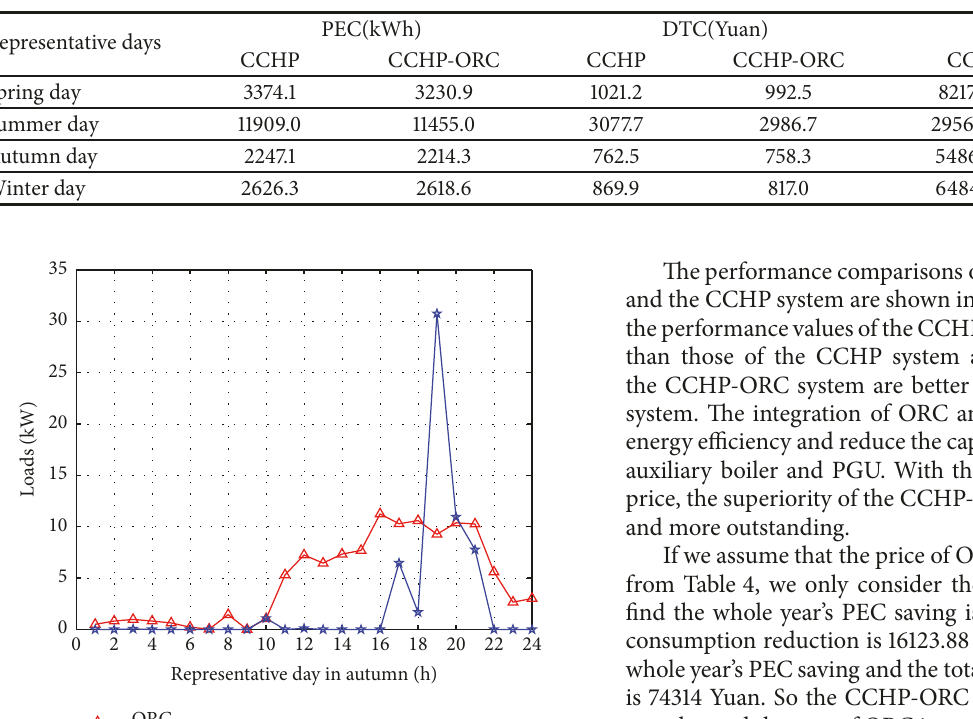
Table 4: Performance comparisons of the CCHP-ORC system and the CCHP system.